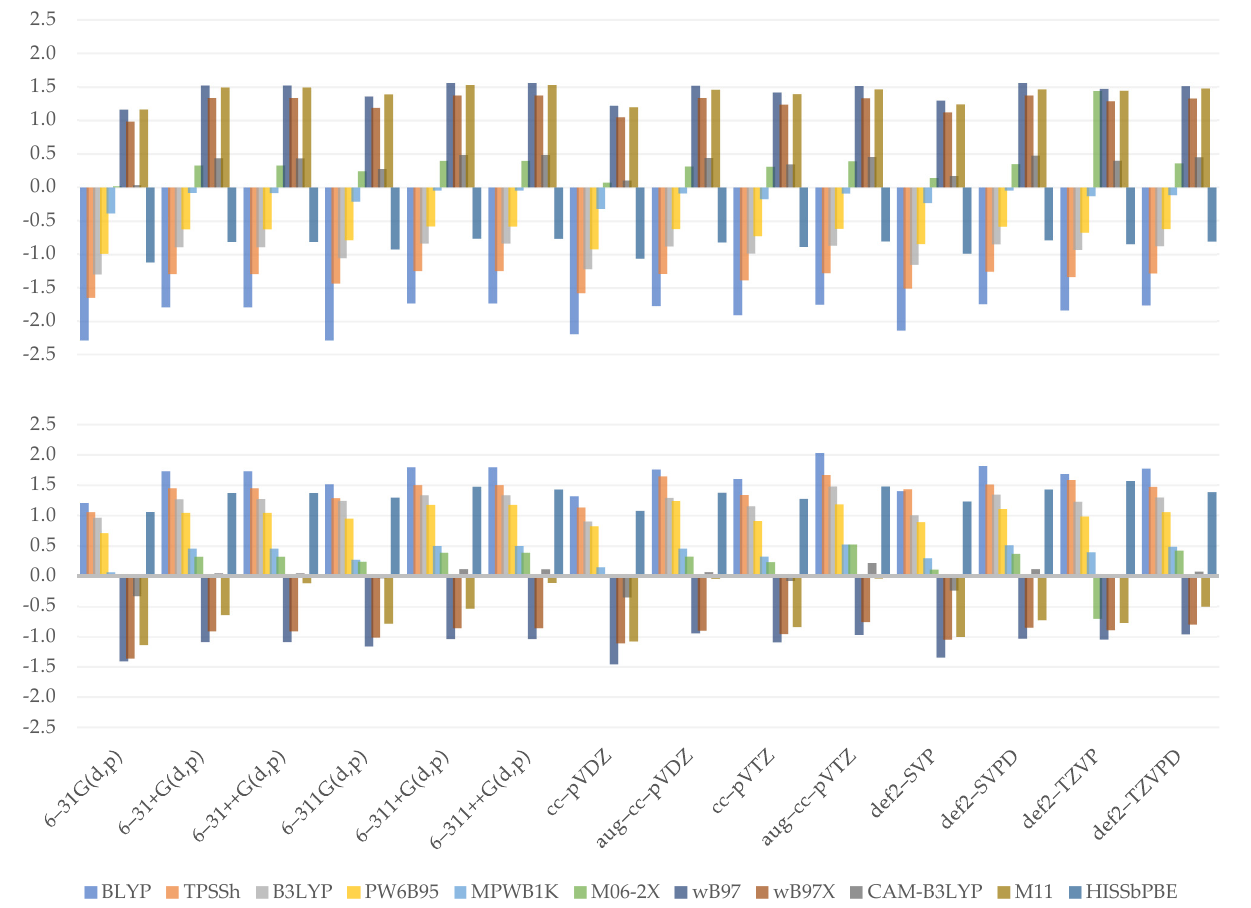
Figure 7. Calculated errors to reference value for vertical ionization potential ( upper ) and vertical electron affinity ( lower ) using Janak’s theorem (eV).